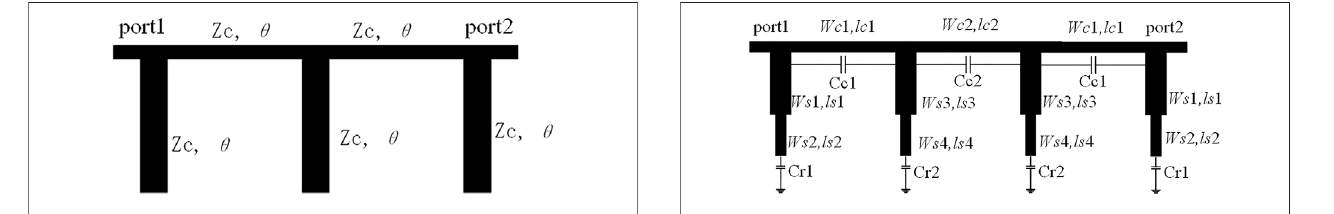
FIGURE 1 | The equivalent circuit of the TLPF.